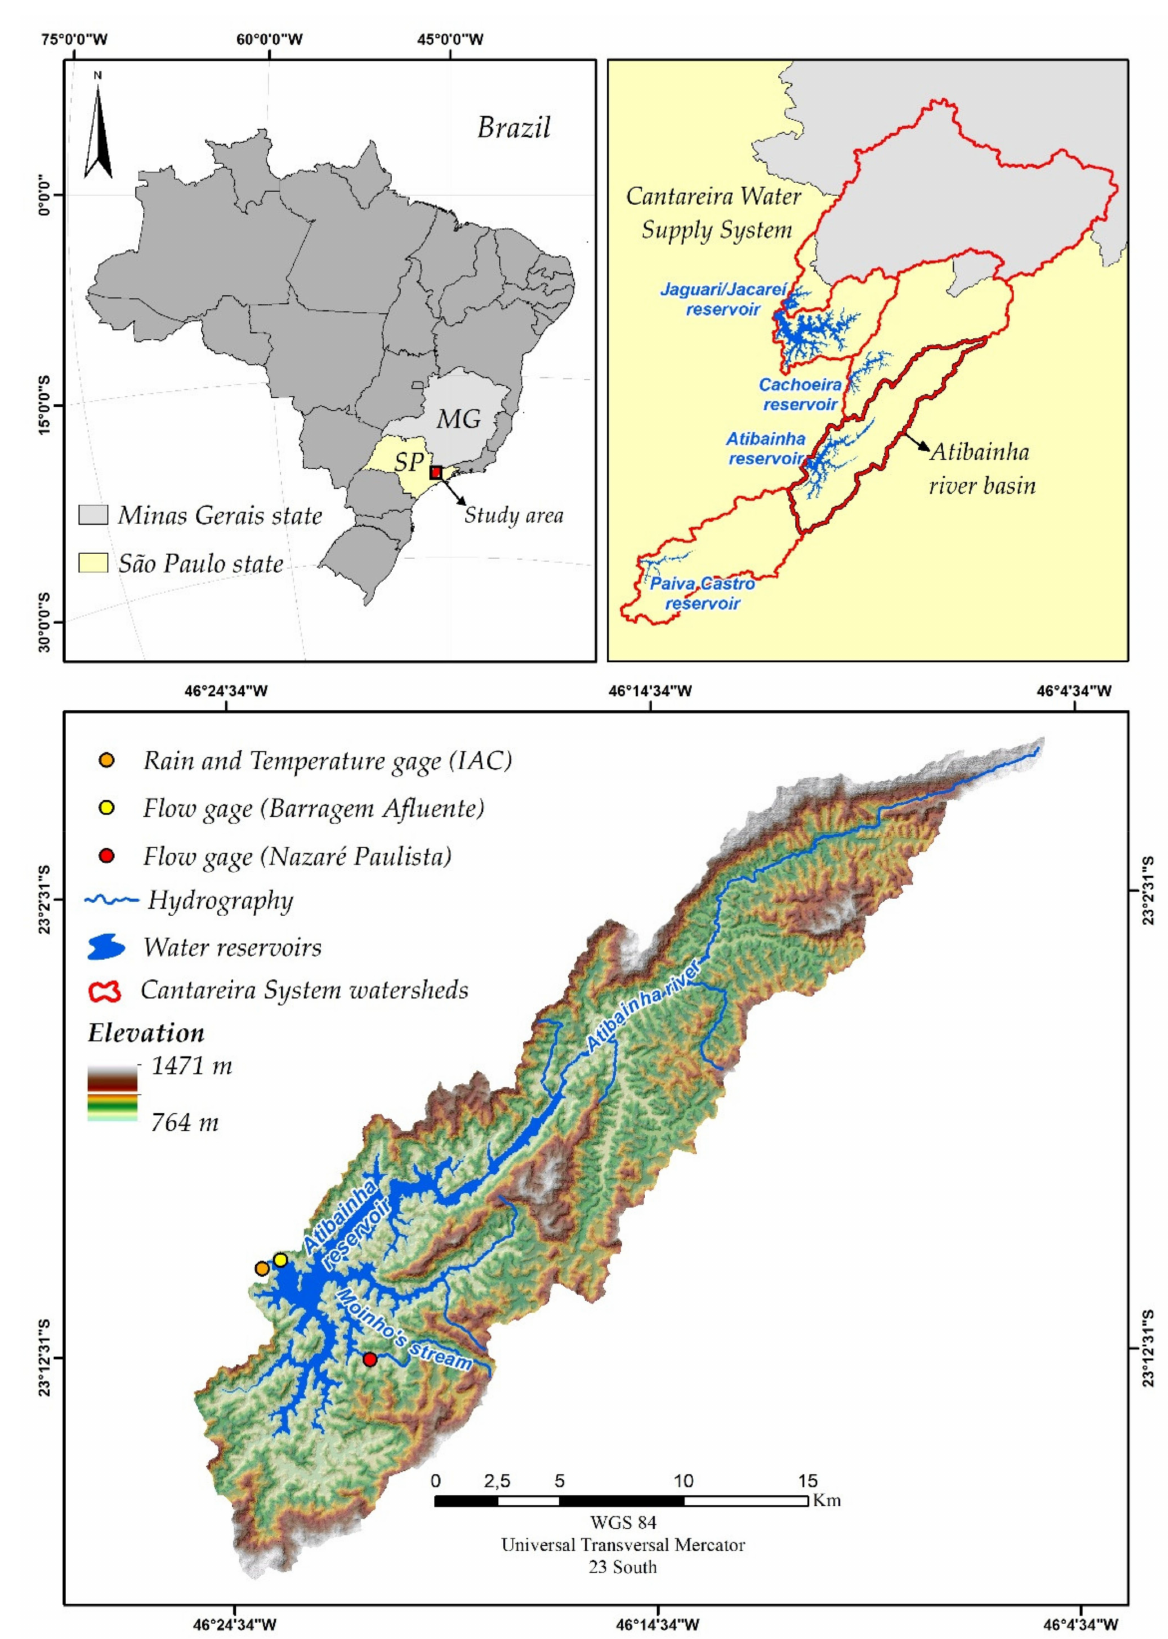
Figure 1. Location of the Atibainha River basin in the state of S ã o Paulo, Brazil, highlighting the region’s